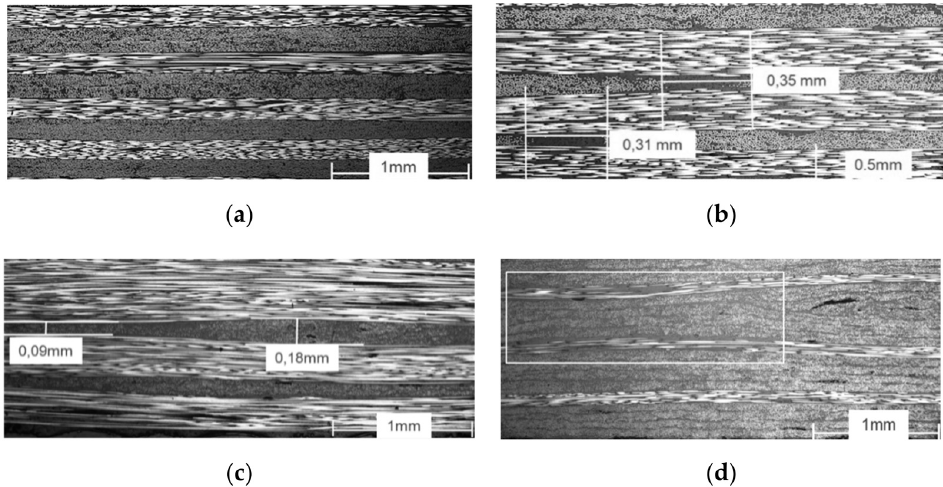
Figure 12. ( a ) Ply configuration [2 × 0 ◦ /2 × 90 ◦ ], no gaps; ( b ) ply configuration 30% 90 ◦ , no gaps, resin accumulation due to spreading failure; ( c ) ply structure 15% 90 ◦ , no gaps, thickness variation due to inhomogeneous spreading; ( d ) ply structure 15% 90 ◦ , 2 mm gaps, gap => local undulation in 90 ◦ plies.